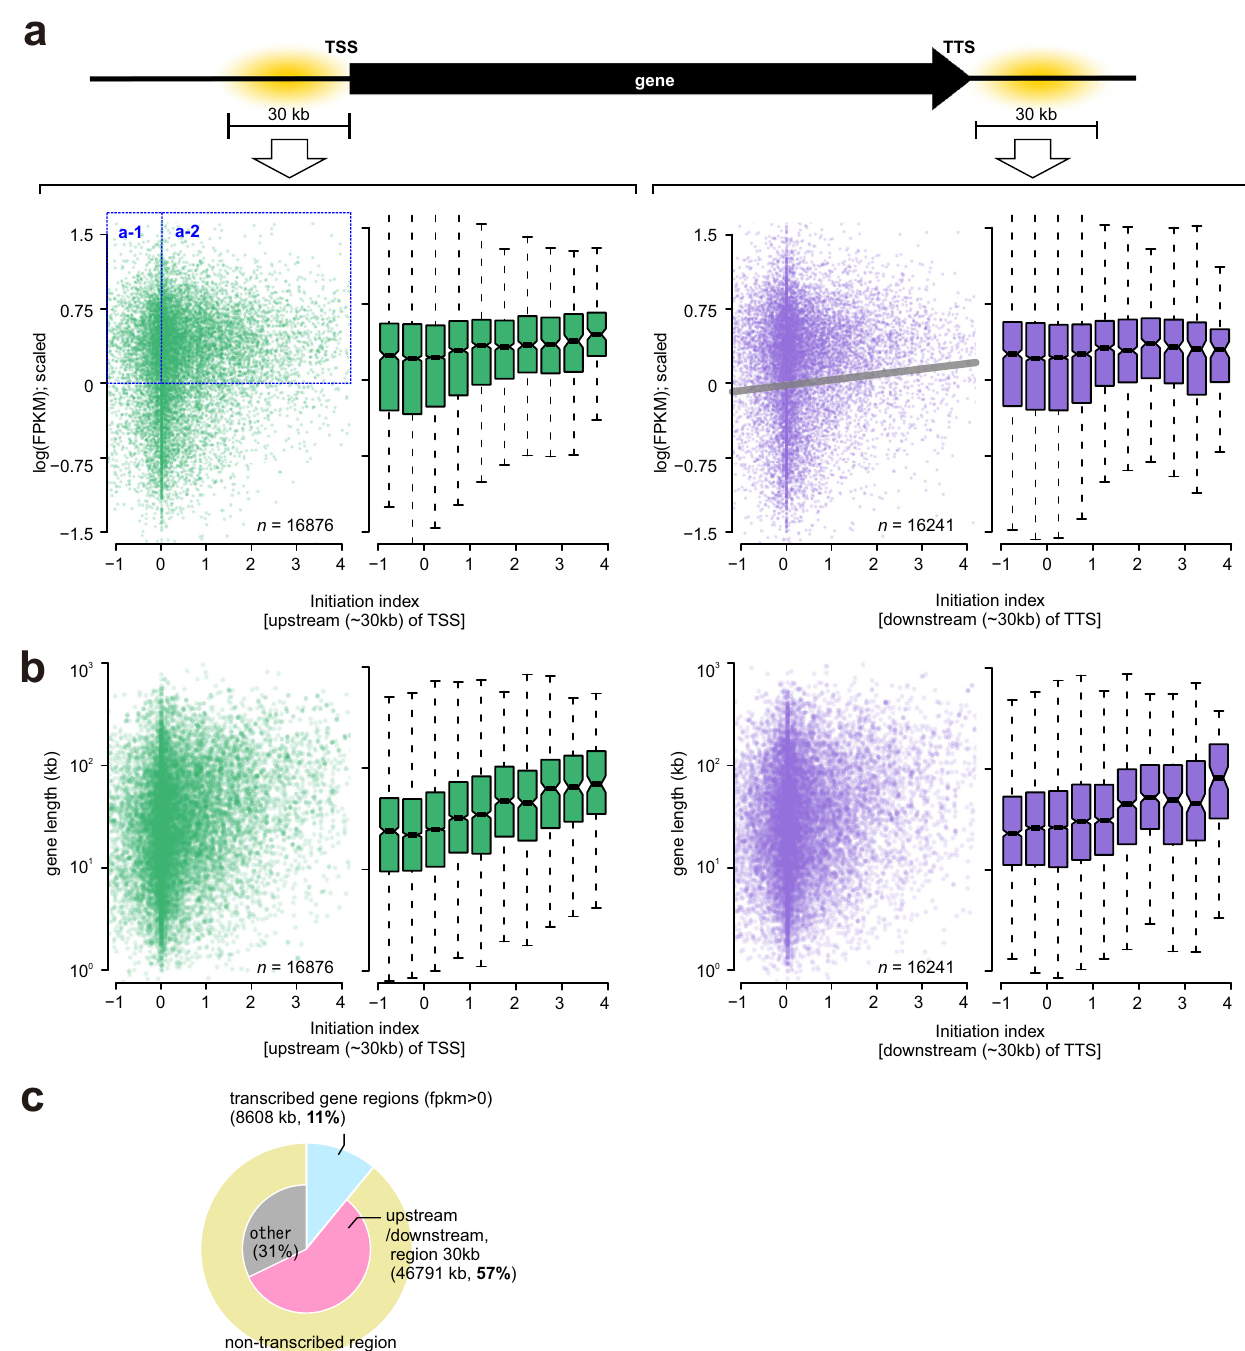
Fig.4|Correlationofinitiationandtranscriptionalactivity.a Top:Schematicof a gene showing TSS and TTS. Bottom: Sum of initiation index within the 0 – 30kb region upstream of TSS (left two panels) and downstream of the TTS (two right panels) are plotted against transcriptional activity for each gene, represented as FragmentsPerKilobaseofexonperMillionmappedreads(FPKM)fromanRNA-seq experiment(thisstudy).SumofinitiationindexisnormalisedtoZ-score(mean=0, standard deviation = 1) and Z(0) is subtracted to maintain the original + or – information. Log(FPKM) is normalised to Z -score ( n =16,876 of TSS and n =16,241 of TTS). b Similar to ( a ), sum of initiation index upstream of TSS (left two panels) and downstream of the TTS (two right panels) are plotted against length of genes